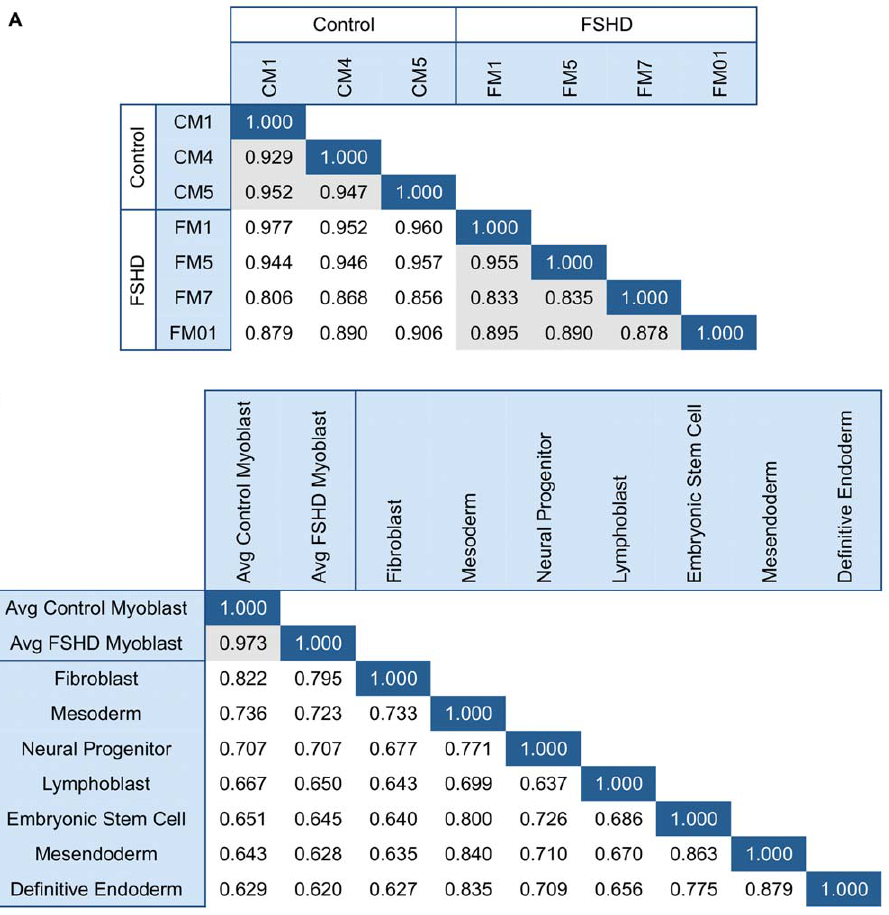
Figure 2. Similarity between FSHD and control myoblast genome-wide replication timing profiles and other cell types. (A) Genome- wide Pearson’s correlations between individual control (begins with ‘‘C’’) and FSHD (begins with ‘‘F’’) primary myoblast timing profiles are displayed. Gray indicates control to control or FSHD to FSHD comparison. One FSHD dataset (FM7) had a low signal to noise ratio and deviates somewhat from other datasets, but was still included for comparison. (B) Genome-wide Pearson’s correlations between averaged control and FSHD myoblasts as well as other human cell types are displayed. Gray indicates control to FSHD myoblast comparison.